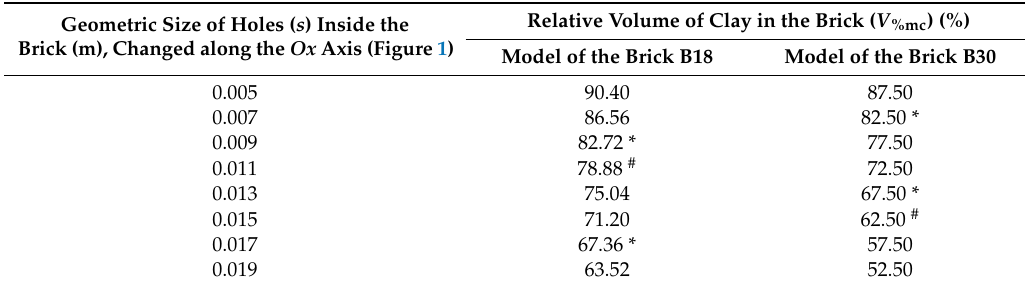
Table 1. Clay percentage inside analyzed bricks.